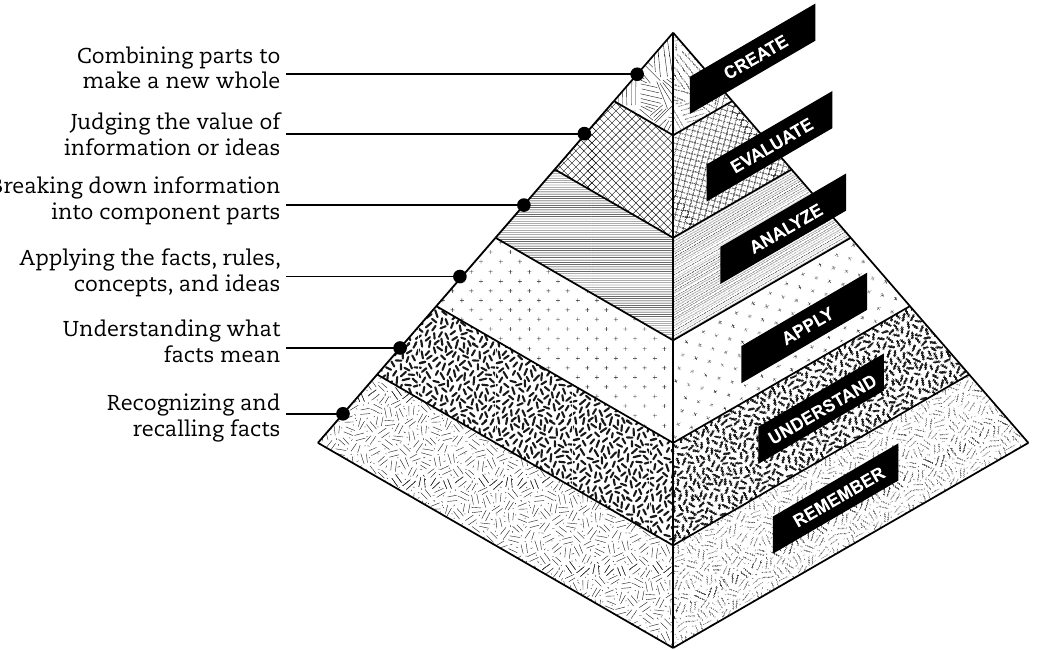
Figure 1: Evolution of Design Teaching: integrating competencies and meta-competences. Department of Design, Politecnico di Milano’s educational models on the left hand side, with authors’ revision of